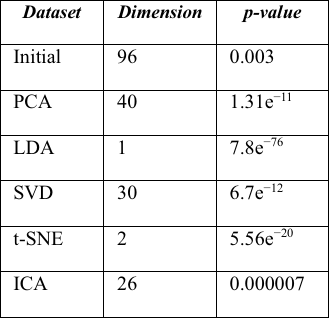
Table 3. Classification performance of decreased and original databases using multiple MLAs in terms of run-